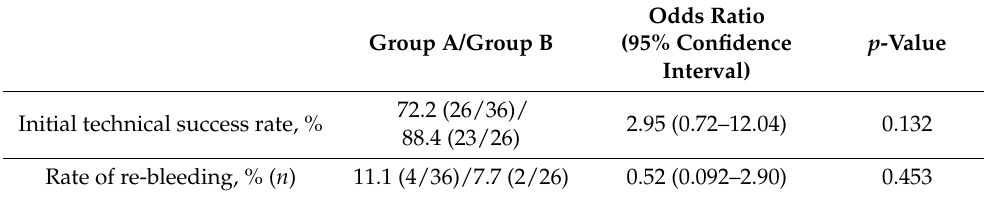
Table 3. Results of endoscopic